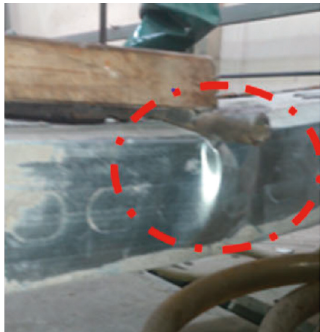
Figure 12: Cracks on the top of the panel in step 1.